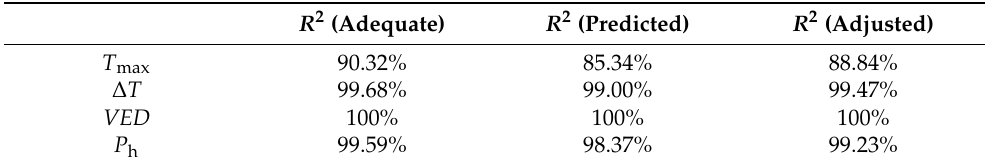
Table 3. Values of R 2 (Adequate), R 2 (Predicted), and R 2 (Adjusted) for the output variables T max , ∆ T , VED , and P h .